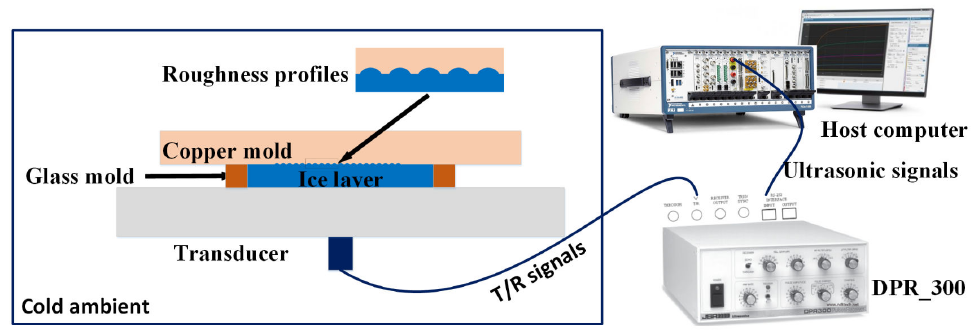
Figure 6. Experimental setup for measurement of roughness Ra via UPE